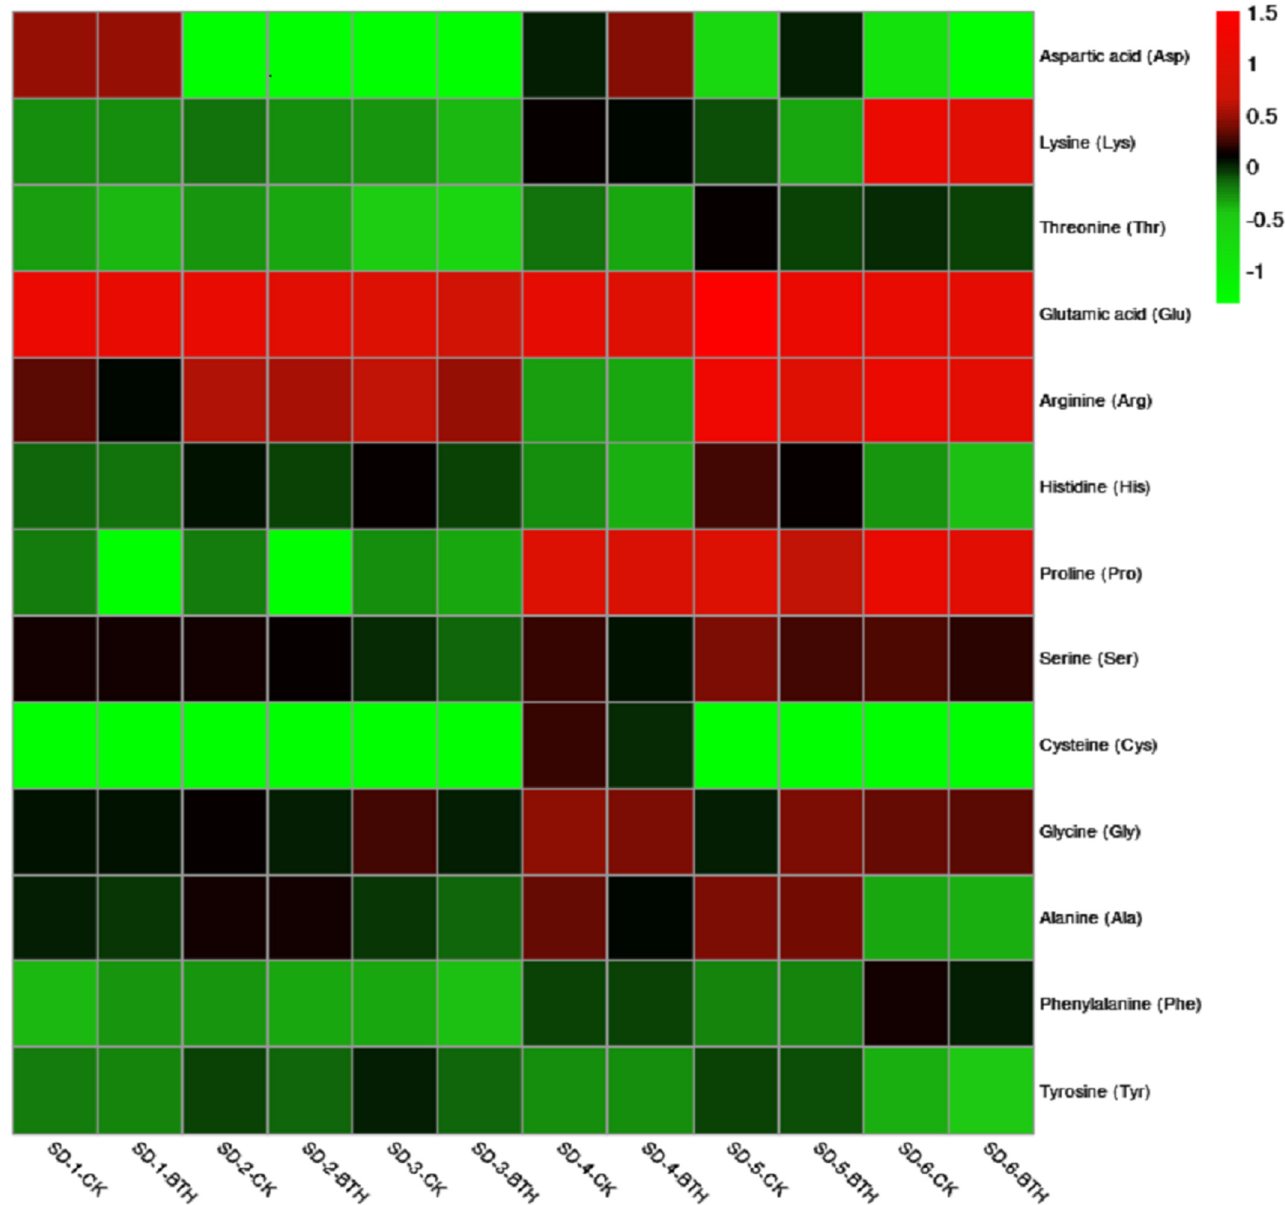
Figure 2. Hierarchical heatmap of detected amino acids in control (CK) and BTH-treated Cabernet Gernischt cv grapes during development; SD; Sampling Date. The color scale shows that compounds with high concentrations range from black to bright red, while compounds with low concentrations range from black to light green. Compounds not detected are designated with very bright green colors.